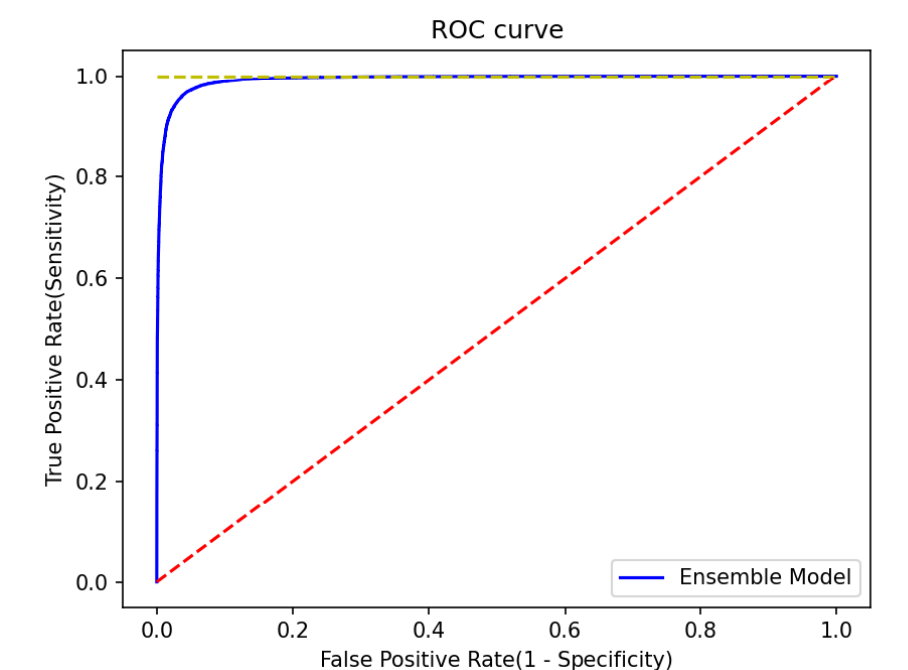
Figure 6. ROC Curve (Weighted Soft Voting).